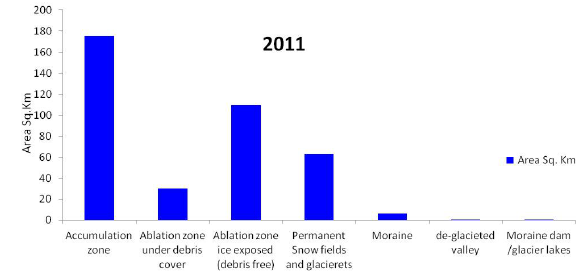
Figure 7: Statistical distributions of glacier features (2011) Broad statistical analysis of data for the Bhaga basin is carried out to understand the distribution of the glaciated area in the basin.